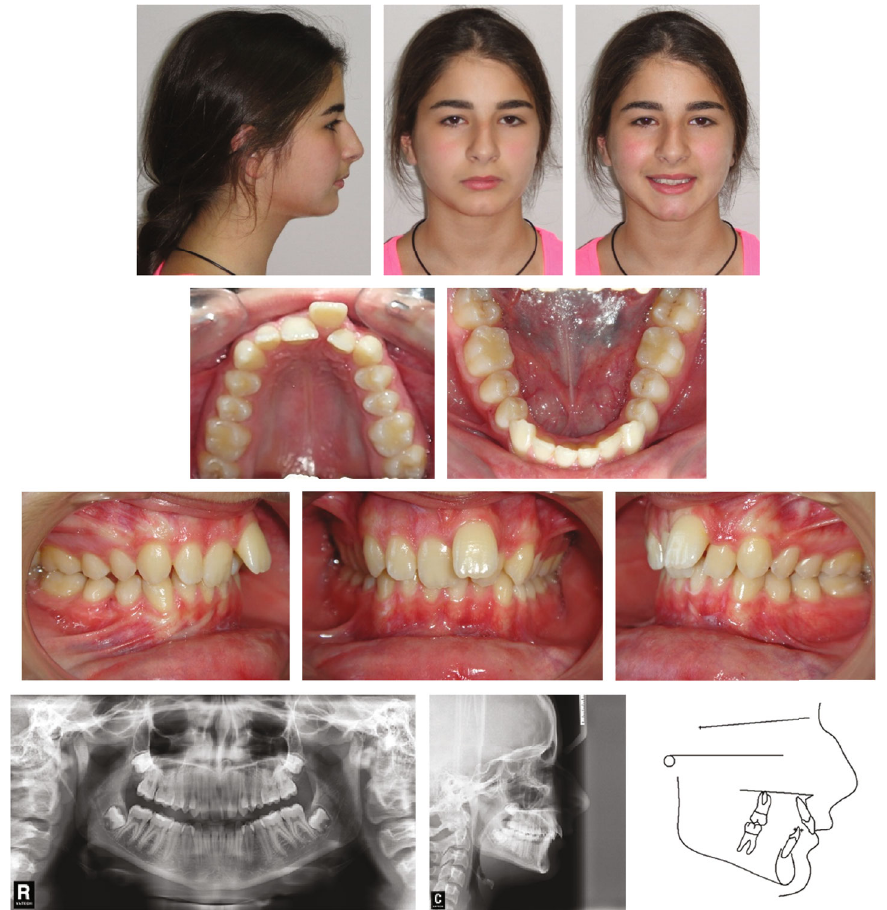
Figure 11: Case 2. 15-year-old female patient with bilateral class II canine and molar relationships, shifted maxillary midline, and blocked- out buccally upper left central incisor before treatment. Table 2: Case 2 cephalometric